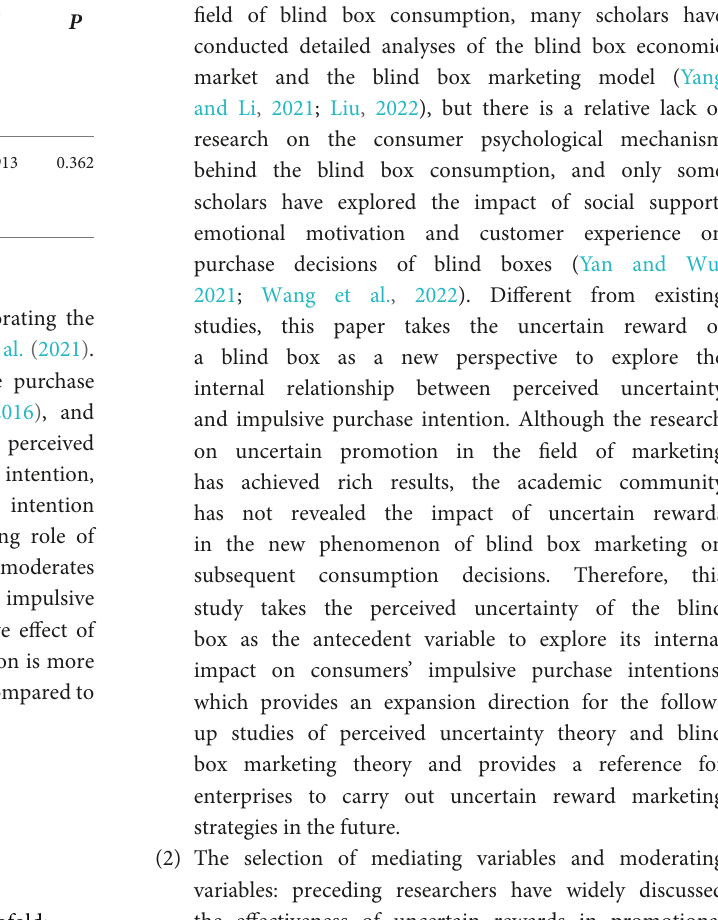
TABLE 9 The result of t